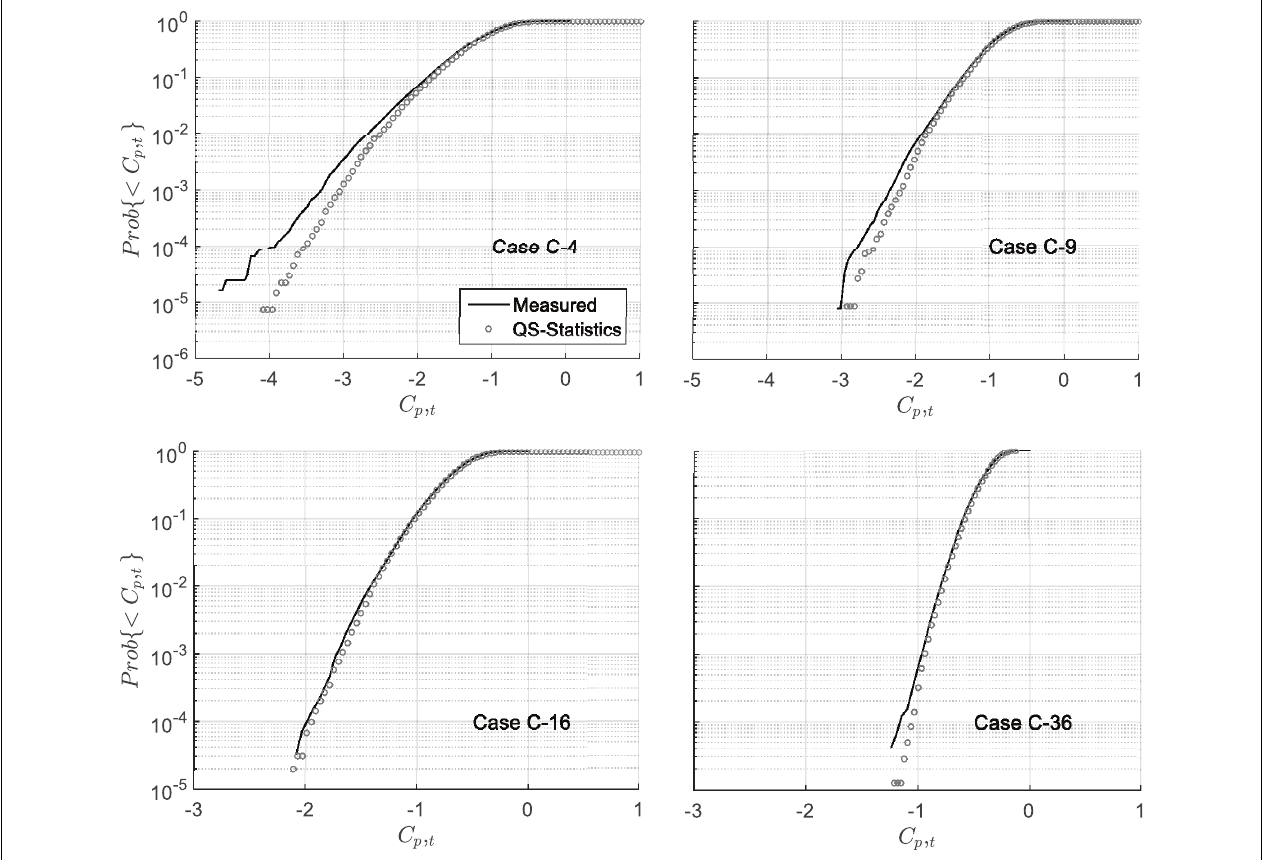
FIGURE 12 | Cdf of C p,t ’s obtained from measurement and QS- θθθ - βββ model for cases C-4, C-9, C-16, and C-36, mean wind azimuth (cid:22) θ (cid:22) θ (cid:22) θ =